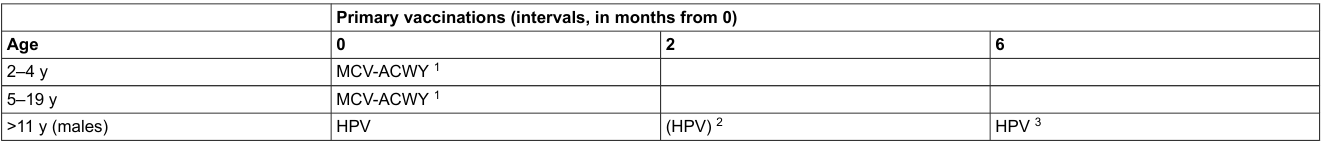
Table 3: Recommended complementary